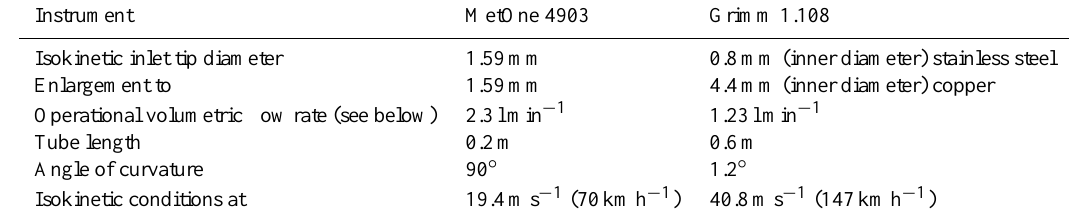
Table A2. Characteristics of the sampling lines for the optical counters used on board of the DIMO research aircraft. Instrument MetOne 4903 Grimm 1.108 Isokinetic inlet tip diameter Operational volumetric flow rate (see below)